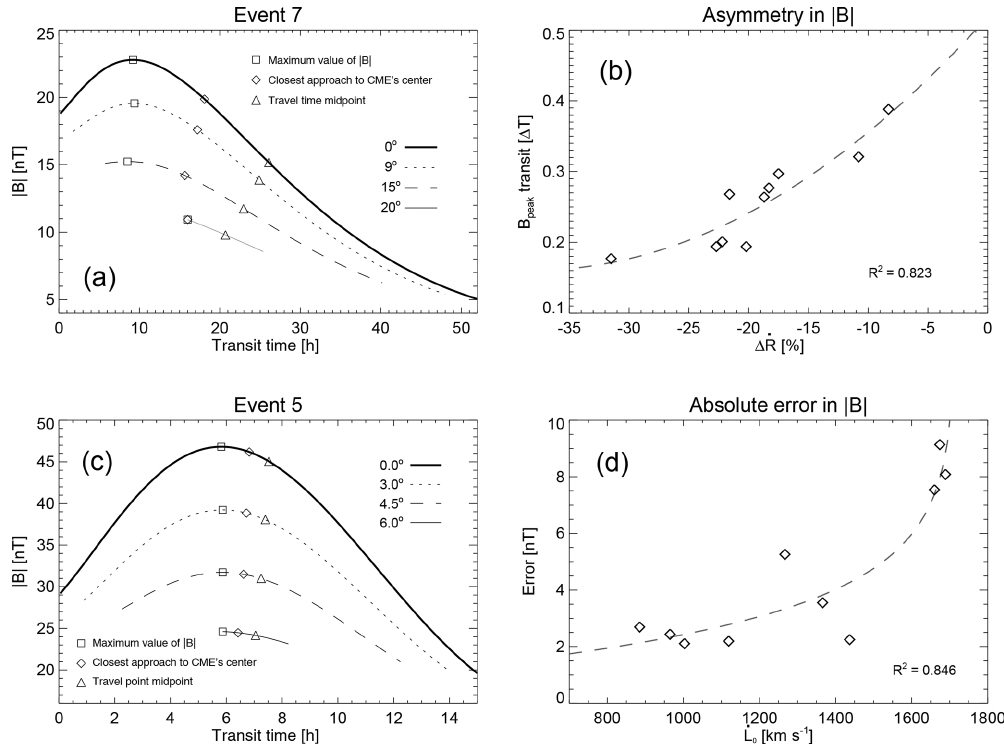
Figure 7. Effects of trajectory and expansion rate on synthetic profiles of magnetic field intensity, and absolute error dependence on initial speeds of CMEs. (a, c) Synthetic profiles for different CME initial orientations for Events 7 (a) and 5 (c) during (cid:49)T . The different profiles correspond to initial CME trajectories deviating from the Sun–Earth line of sight. The open squares and open diamonds point out the maximum value of | B | and the closest approach to the CME center, respectively. (b) Transit of magnetic intensity peak, in terms of transit times, vs. (cid:49) ˙ R for all events. (d) Absolute error for synthetic profiles of magnetic intensity. The calculated absolute errors as a function of ˙ L 0 . In (b) and (d) the dashed lines are the performed regression for the